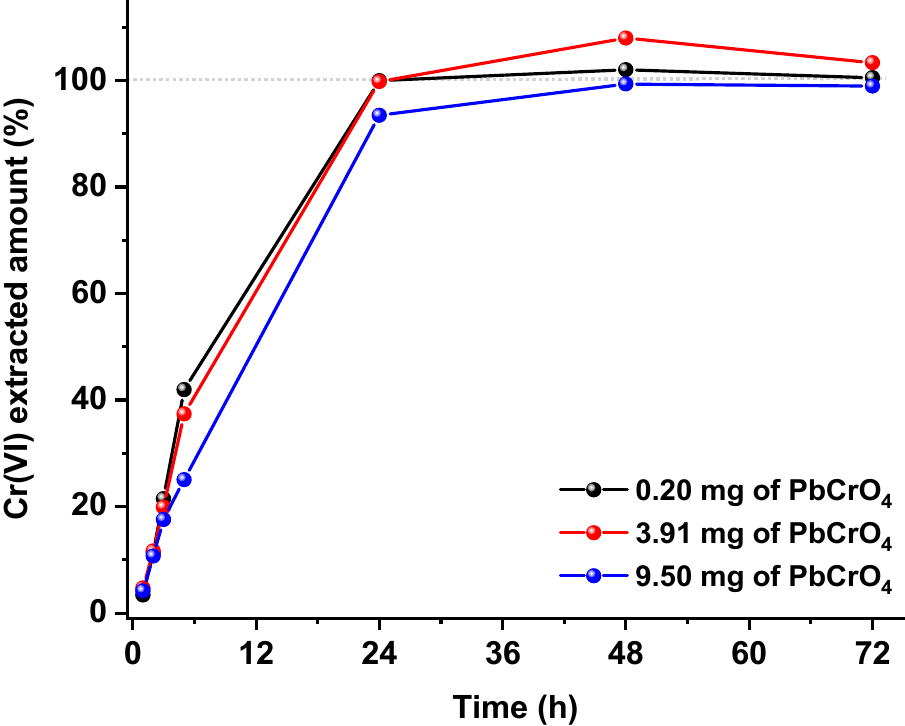
Figure 3. Extraction profiles of PbCrO 4 at room temperature with 50 mL of the ISO phosphate buffer: the three curves refer to three independent extractions carried out with increasing PbCrO 4 loadings.